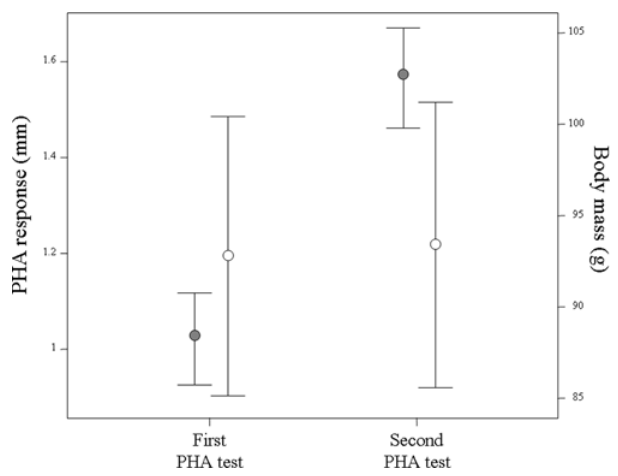
Figure 1. Local tissue swelling (black dots) and body mass (white dots) of 125 birds subjected to two successive PHA-skin